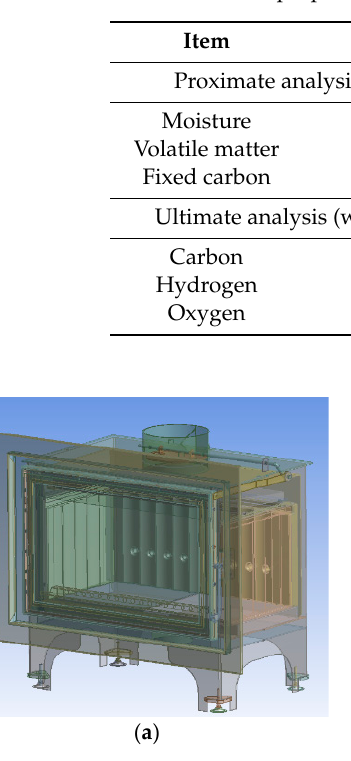
Table 1. Basic properties of wood.